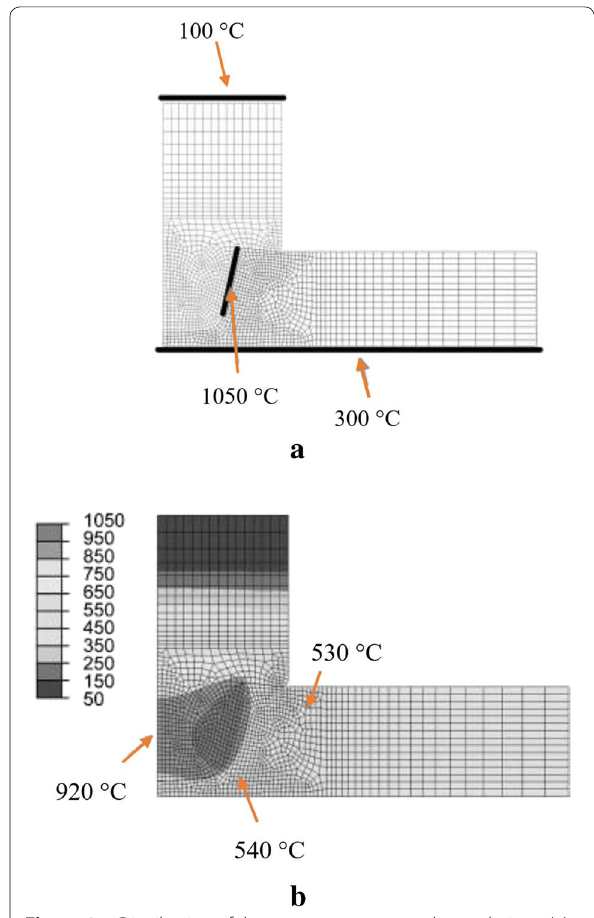
Figure 37 Distribution of the temperature across the workpiece: ( a ) thermal model, ( b ) the simulated model [129]